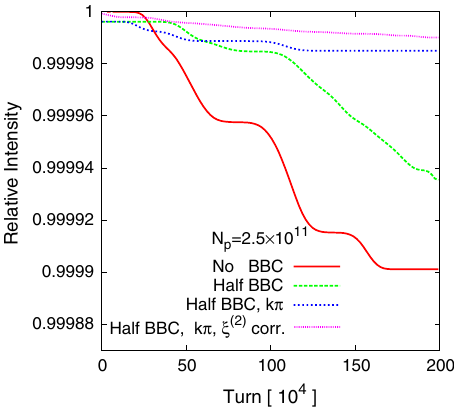
FIG. 16. Proton beam losses in 2 (cid:2) 10 6 turns with 5 different sets of initial macroparticle coordinates. Proton bunch intensity is 2 : 5 (cid:2) 10 11 . Half beam-beam compensation is used. The calculated proton beam loss rate from the 5 cases is ð 1 : 1% (cid:6) 0 : 2% Þ = hour .